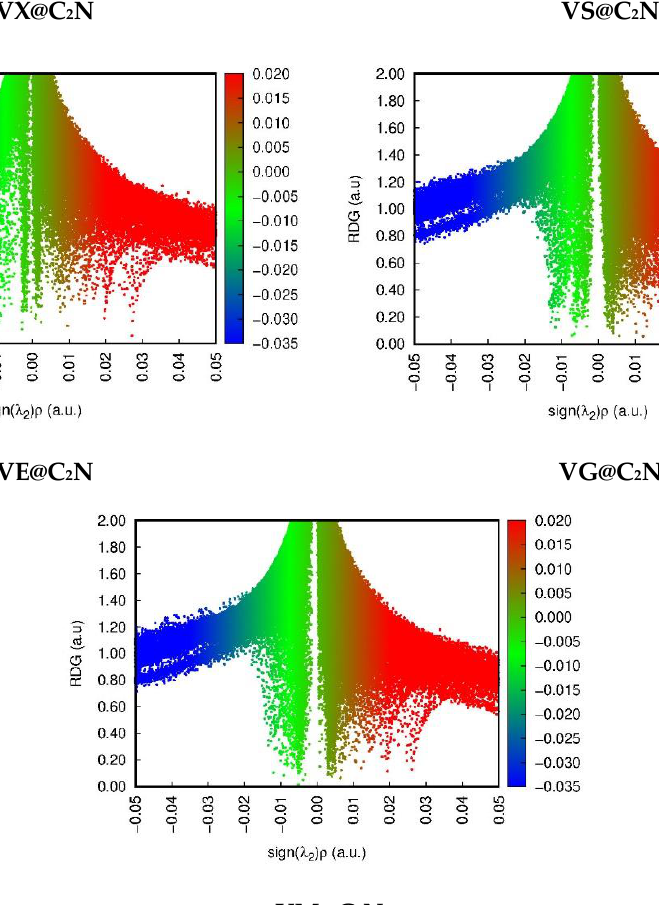
Figure 5. 2D-RDG plots of studied complexes via NCI analysis.